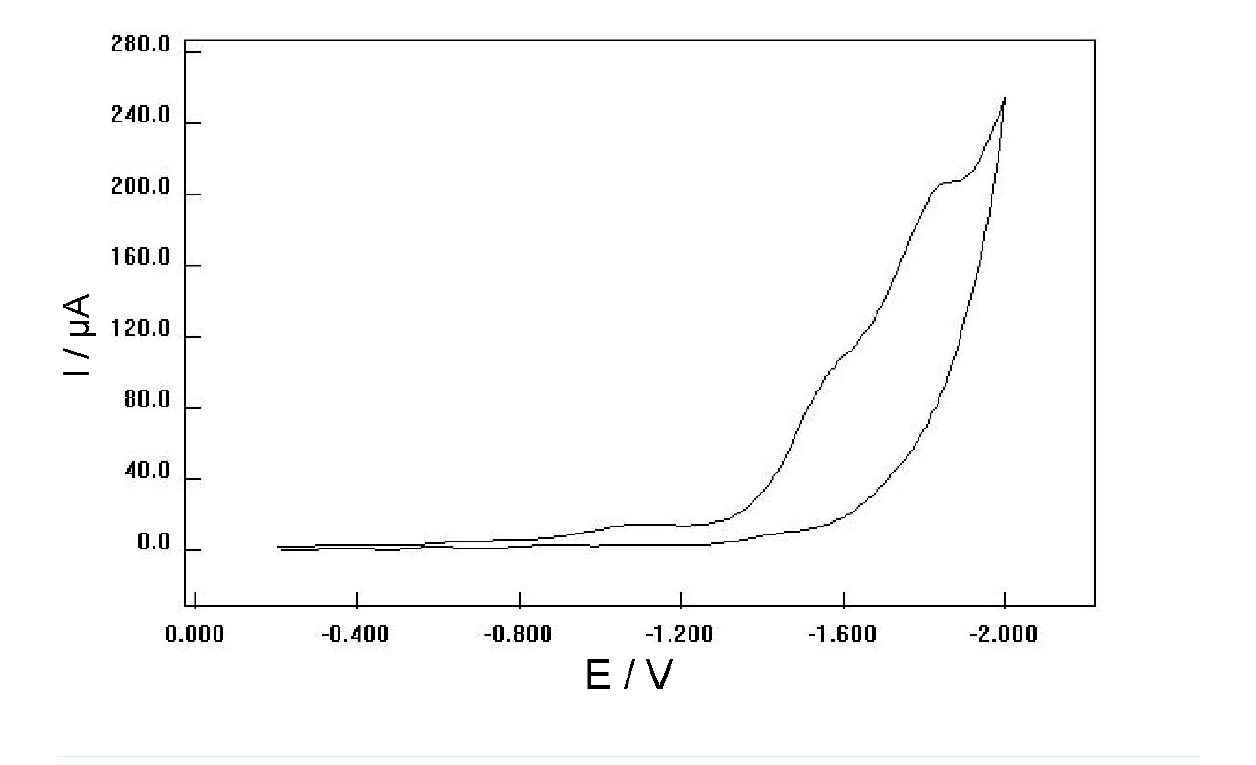
Figure 5. Cyclic voltammogram of NDELA (1 × 10 –3 M) on an Hg/Au electrode in Britton-Robinson buffer (pH 6.19) at a scan rate of 25